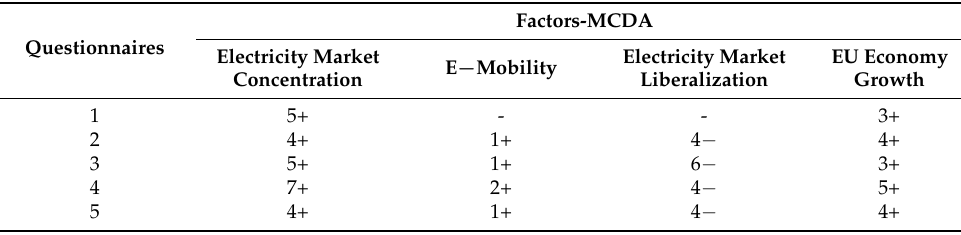
Table A6. Consistency check of the experts’ answers, multiple-criteria decision analysis—interquartile range calculation (last line), empty cells (-) define no answers